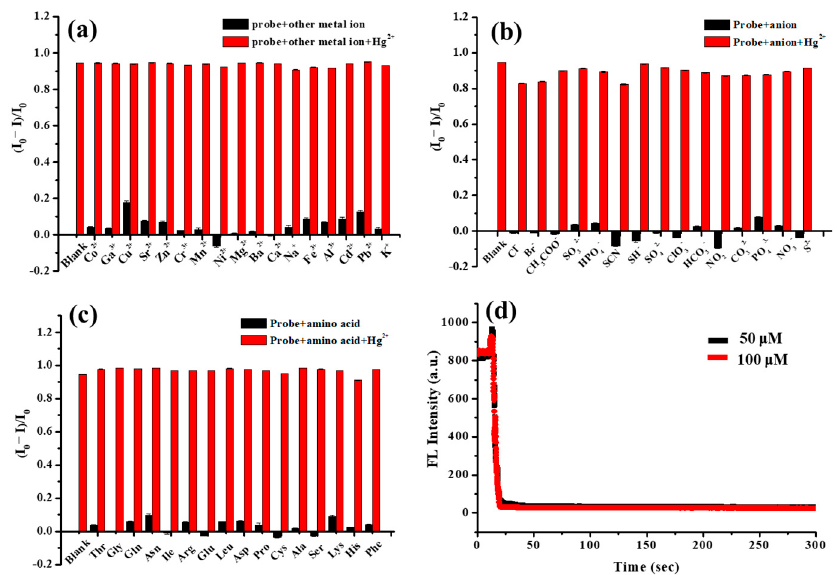
Figure 7. Fluorescence response of FA-PDA FONs probe upon addition of ( a ) 18 metal ions, ( b ) 15 anions, and ( c ) 16 amino acids, respectively, and the concentrations of metal ions, cations, and amino acids are 50 µ M. ( d ) FL intensities of FA-PDA FONs probe after addition of 50 µ M (black line) and 100 µ M (red line) Hg 2+ as a function of time.